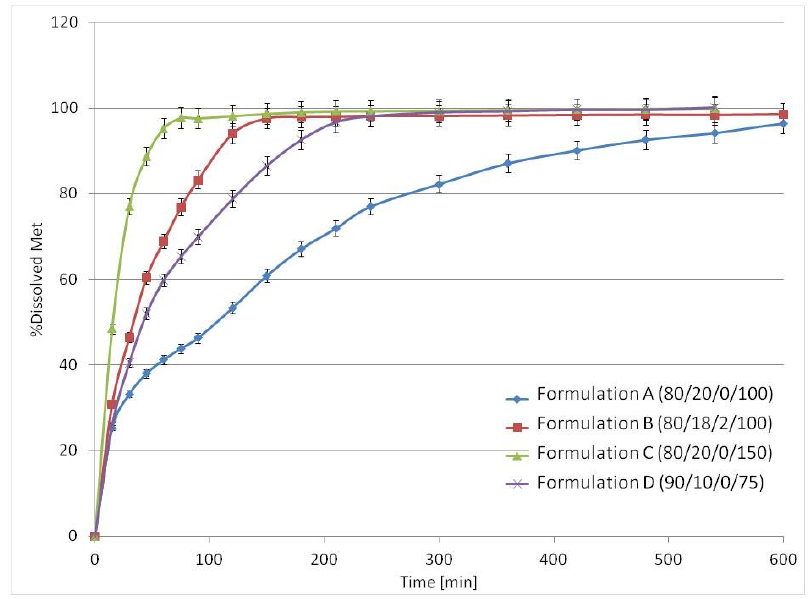
Figure 10. The mean release profiles ( n = 3) of Met from 3D printlets in the USP3 apparatus.